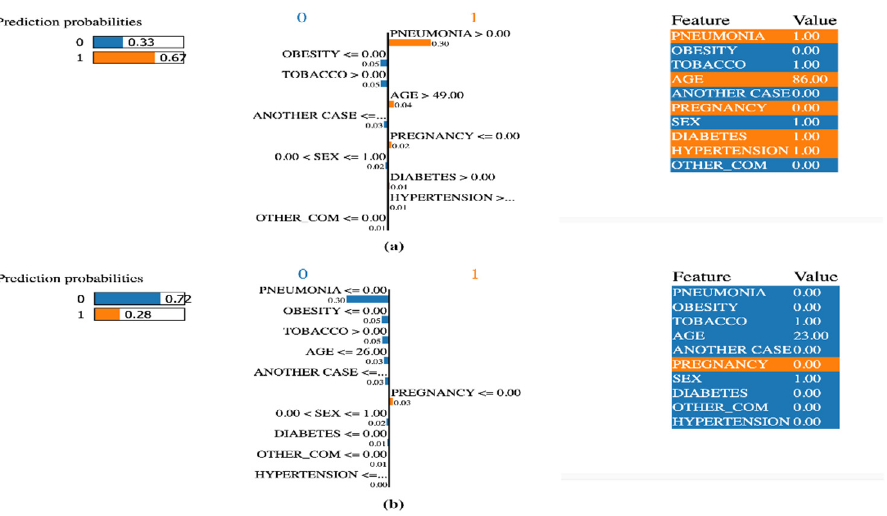
Figure 11. ( a ) COVID-19 positive diagnosis using LIME. ( b ) COVID-19 negative diagnosis using LIME.